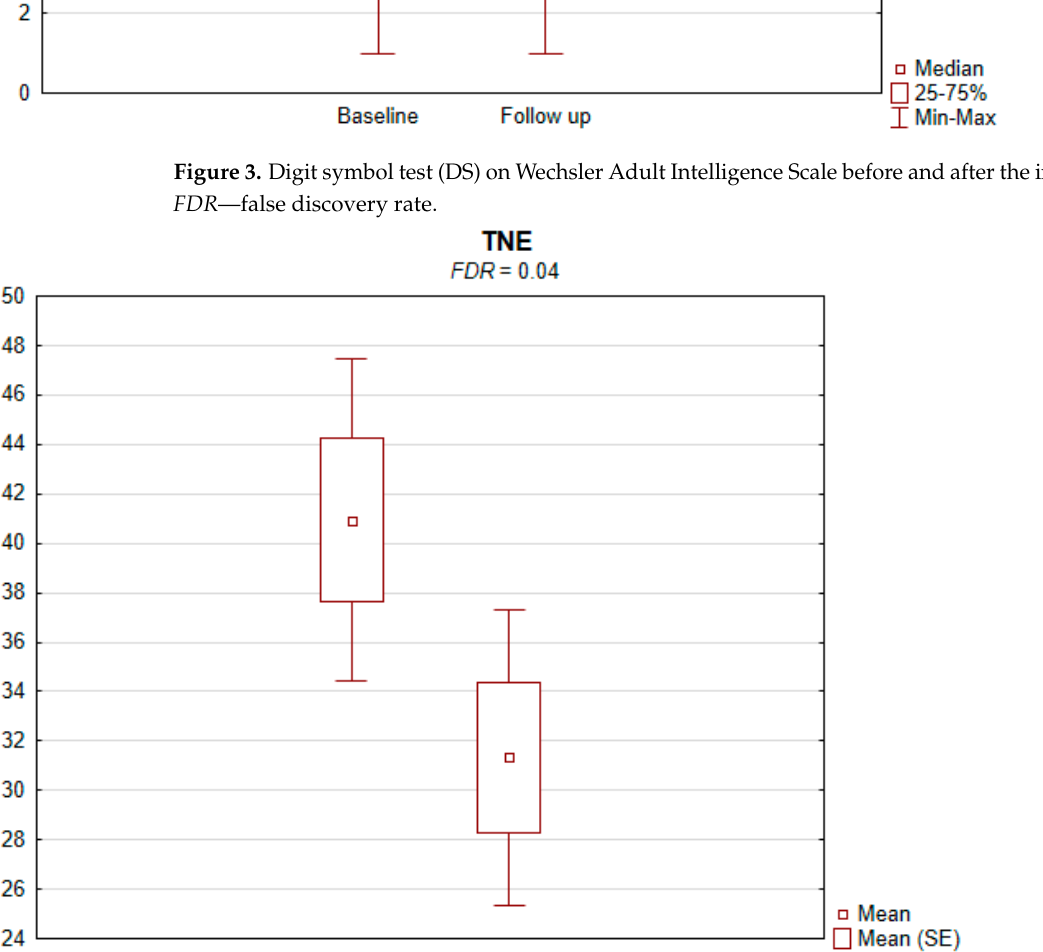
Figure 4. Total number of errors (TNE) in Wisconsin Card Sorting Test before and after the intervention. FDR —false discovery rate.